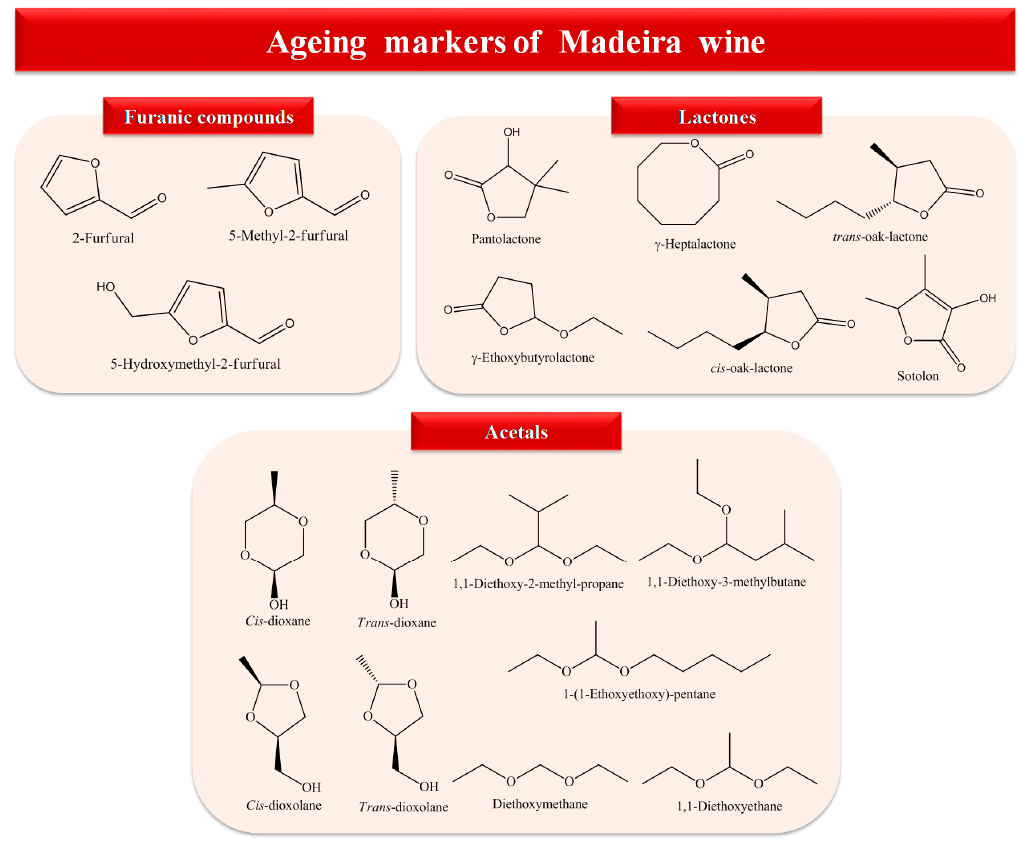
Figure 5. Potential ageing markers of Madeira wines [57,58,77,80,82].